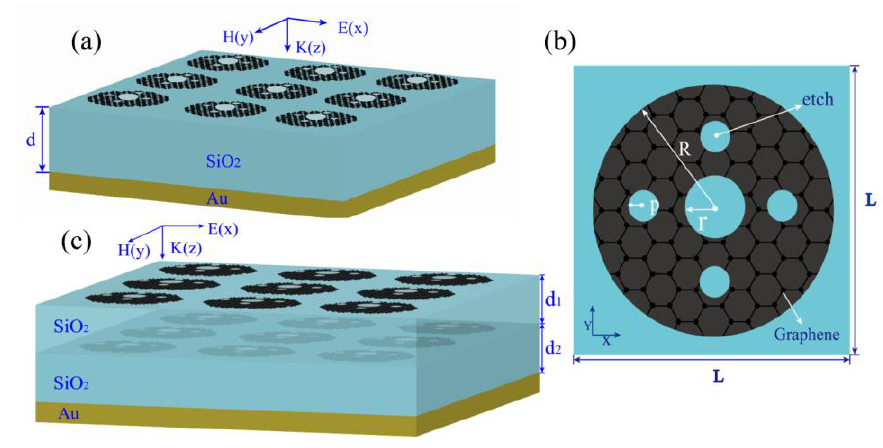
Figure 1. ( a ) Schematic diagram of an absorber composed of toroidal porous graphene, medium, and Au. ( b ) Unit cell of the absorber, in which the values of R , r , and p are 6.5 µ m, 2.05 µ m, and 1.3 µ m, respectively. ( c ) Double-layer graphene metasurface structure, in which the value of d 1 and d 2 are 12 µ m and 16 µ m, respectively.